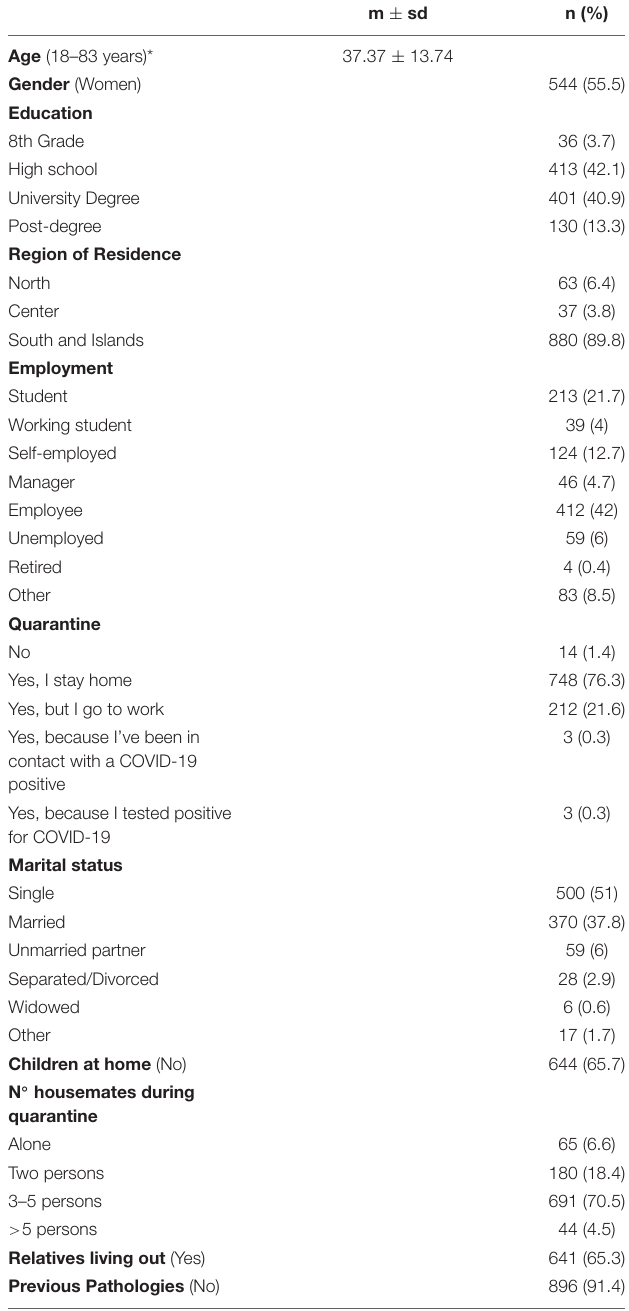
TABLE 1 | Sample socio-demo